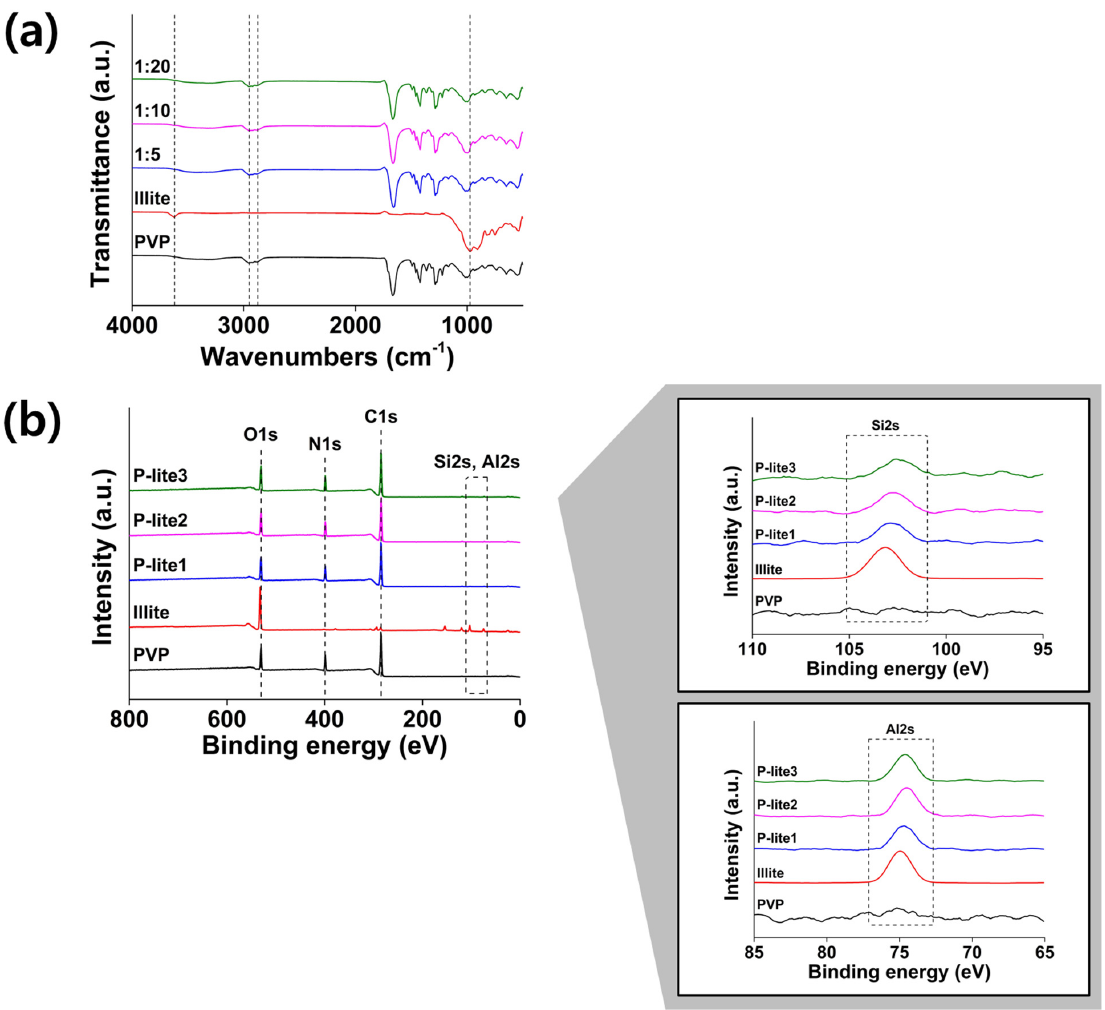
Figure 4. ( a ) Fourier transform infrared and ( b ) X-ray photoelectron spectra of PVP, illite, and P-lite MPs. PVP, polyvinylpyrrolidone; P-lite MP, PVP-stabilized illite microparticles; P-lite1, 1:5 weight ratio of illite:PVP; P-lite2, 1:10 weight ratio of illite:PVP; P-lite3, 1:20 weight ratio of illite:PVP; a.u., arbitrary units.